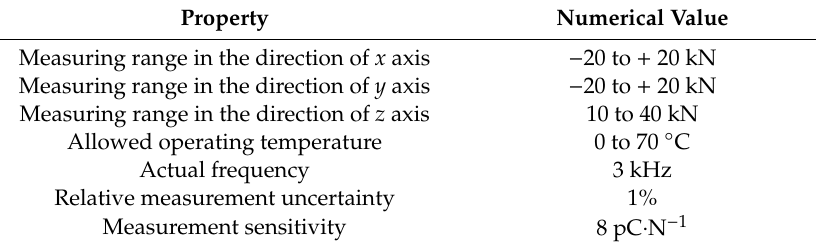
Table 3. Basic technical data for the three-component piezoelectric dynamometer. Property Numerical Value Measuring range in the direction of x axis − 20 to + 20 kN Measuring range in the direction of y axis − 20 to + 20 kN Measuring range in the direction of z axis 10 to 40 kN Allowed operating temperature Relative measurement uncertainty Measurement